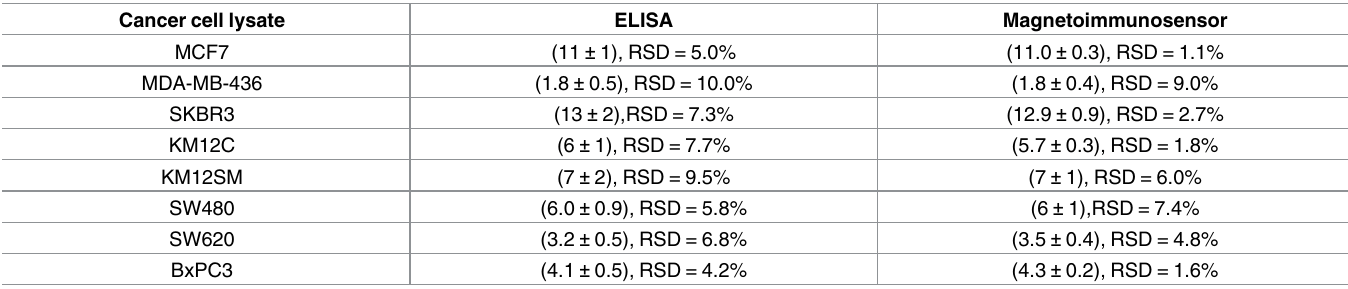
Table 2. Determination of endogenous FGFR4 concentration (in pg μ g -1 ) in different cancer cell lysates (2.5 μ g). Comparisonof the results provided by the developed amperometric immunosensor with those obtainedusing a commercialELISA spectrophotometric kit by performing three different determina- tions over the same cell